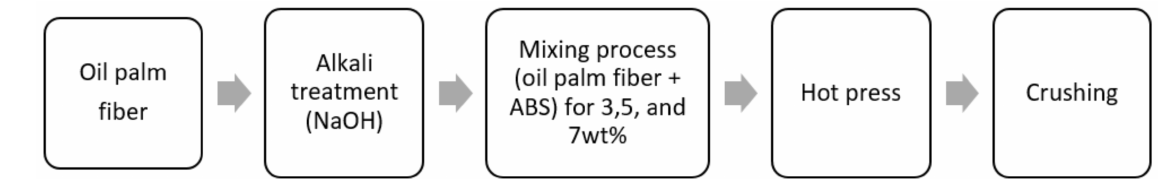
Figure 2. Flow chart for the preparation of oil-palm-fiber-reinforced thermoplastic composites.